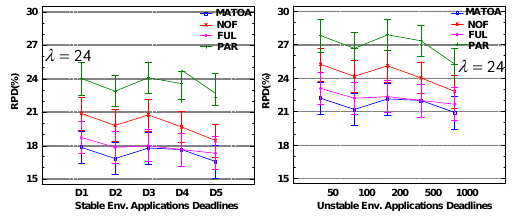
Stable Env. Applications Figure 8. Workload Analysis and Deadlines